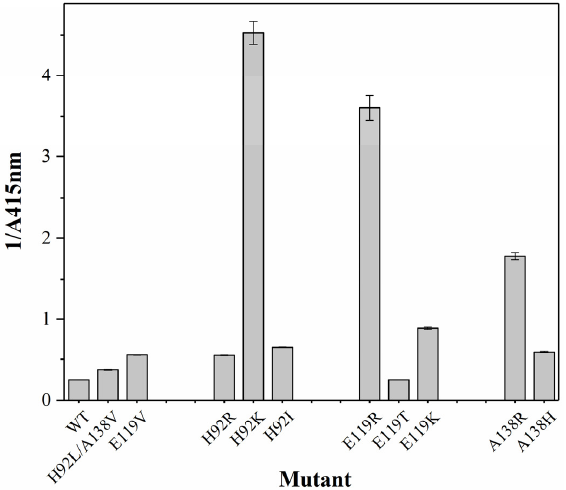
Figure 3. The re-screening results of WT, H92L/A138V, E119V, H92R, H92K, H92I, E119R, E119T, E119K, A138R, and A138H show that H92K, E119R, and A138R are the best mutations at the three sites, respectively (the higher the value of 1/A 415nm , the higher the catalytic